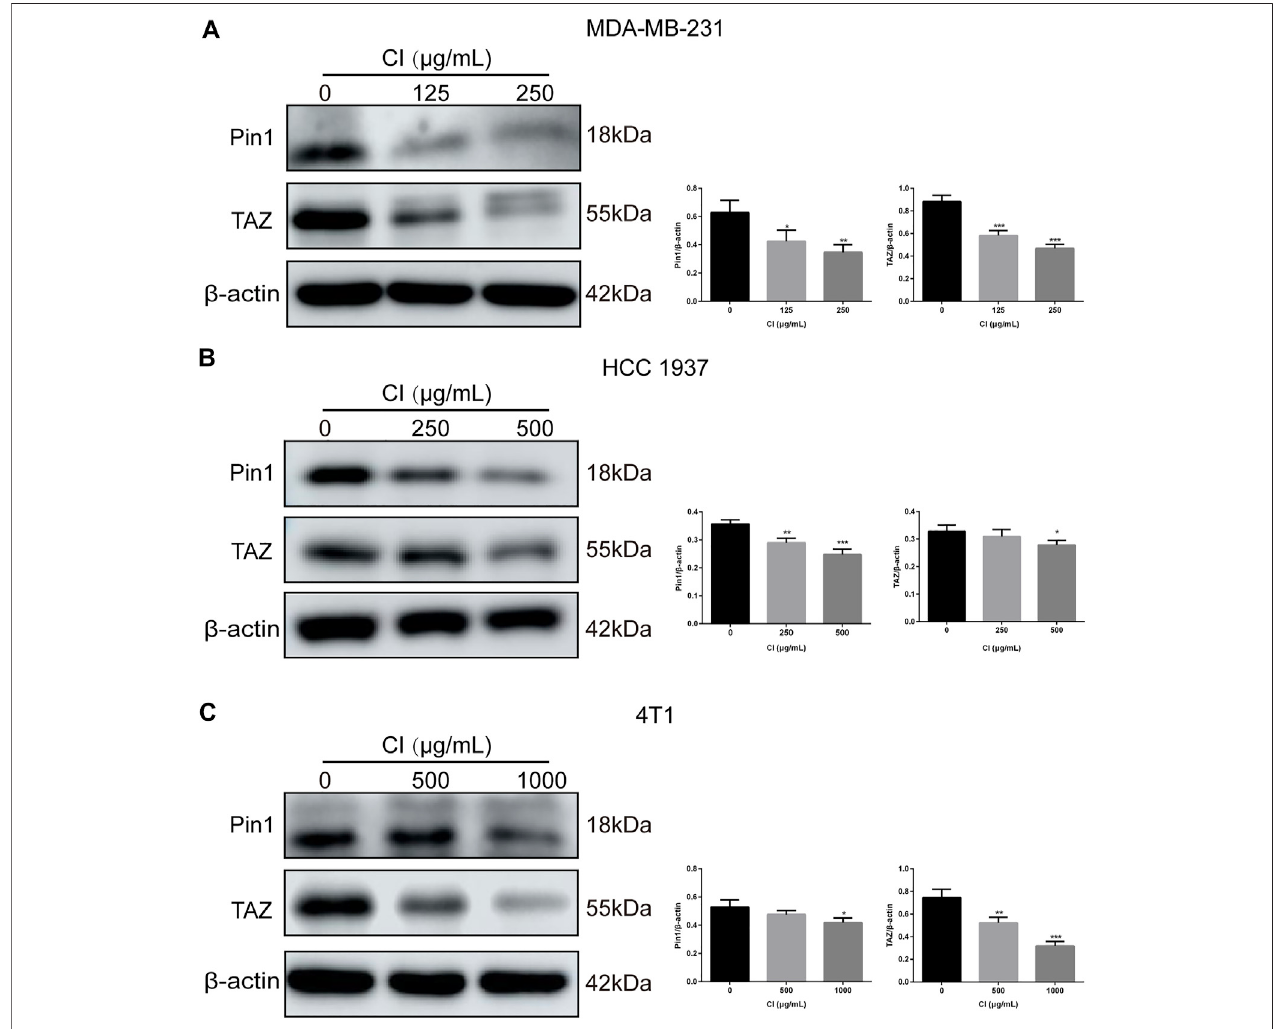
FIGURE6| CIregulatesthePin1 – TAZsignalingpathwayinTNBCcells. (A) LevelsofexpressionofPin1andTAZinMDA-MB-231cellstreatedwithCI. (B) Levelsof expression of Pin1 and TAZ in HCC 1937 cells treated with CI. (C) Levels of expression of Pin1 and TAZ in 4T1 cells treated with CI.